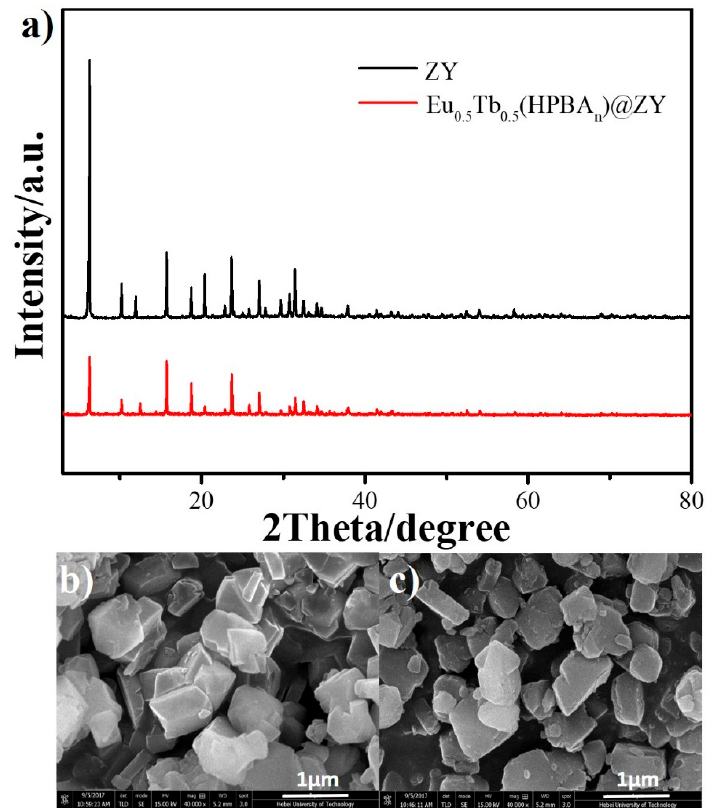
Figure 1. XRD patterns ( a ) and SEM images of ZY ( b ) and Eu 0.5 Tb 0.5 (HPBA n )@ZY ( c ).